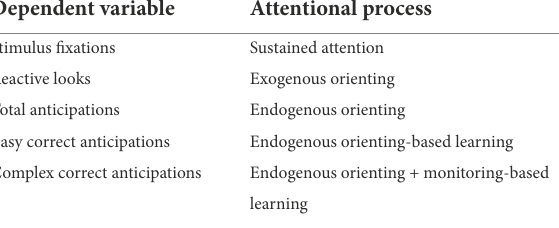
TABLE 1 Summary of the main dependent variables of the VSL task and their associated attentional